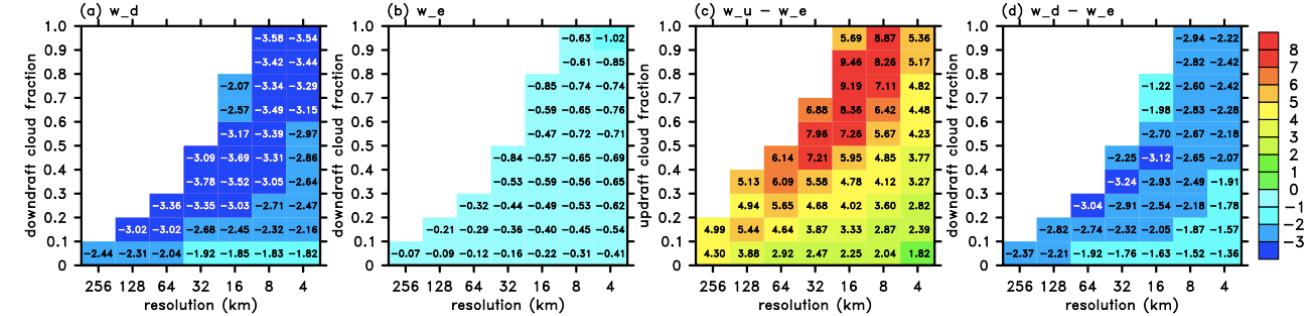
Figure 8. Vertical velocity for ( a ) downdraft; ( b ) environment; ( c ) the difference between updraft and environment; and ( d ) the difference between downdraft and environment as functions of cloud fraction and subdomain size at 500 hPa.